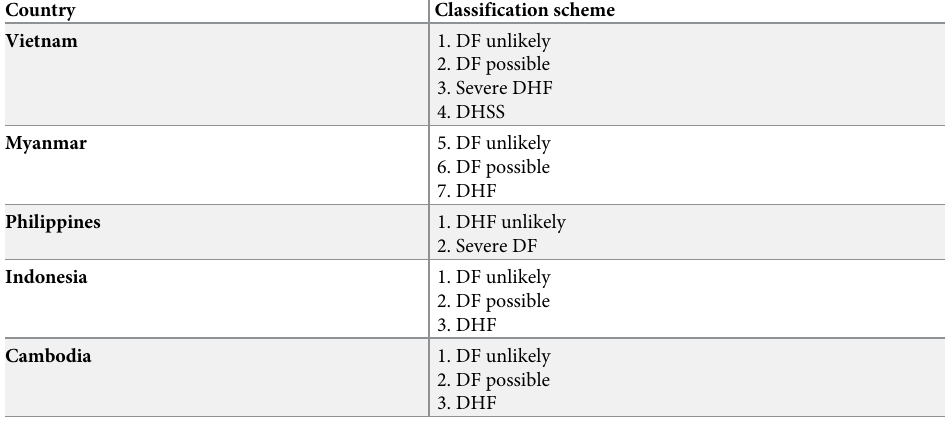
Table 1. Classification of clinically-suspected dengue in five Southeast Asian Integrated Management of Child- hood Illness (IMCI) adaptations (for children 2 months to 5 years of age).